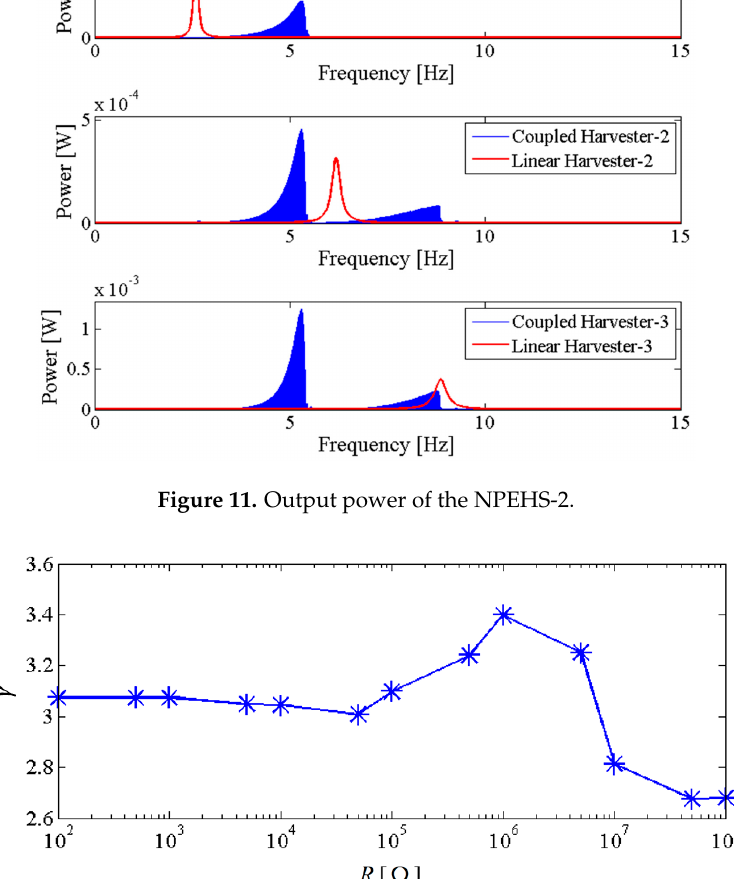
Figure 13. Bifurcation diagram of response voltages versus excitation levels. When the excitation level is 0.1 g, Figures 14 and 15 show that the output voltage of the coupled harvester-2 is larger than the coupled harvester-1, and the response voltage of the former is singly periodic. However, the Poincare map in the phase trajectory of the coupled harvester-1 consists of a series of discrete dots, as shown in the first plot of Figure 14. Its time-domain output voltage is the sine curve with fluctuating. The corresponding spectrum in Figure 14 shows that the fundamental harmonic is the uppermost component, while there is a non-ignorable 2.67 Hz fractional frequency component which modulates the fundamental harmonic.